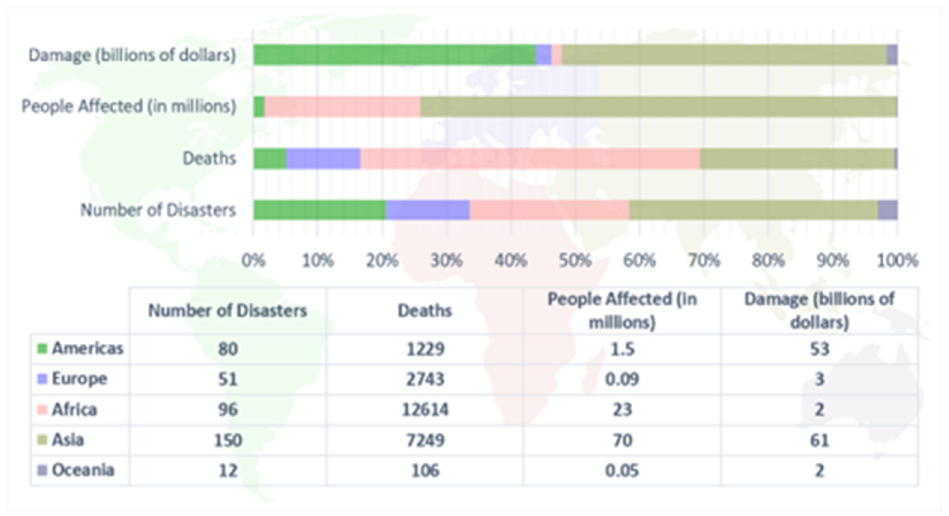
Figure 1. Occurrence, deaths, affected population, and damage of disasters. Adapted from [13] (p. 15).